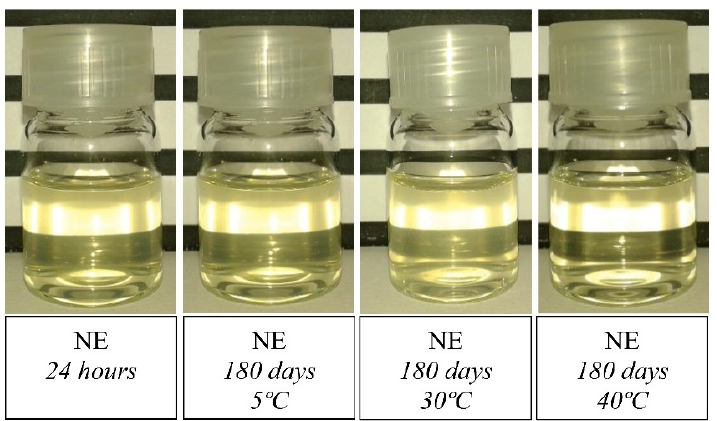
Figure 2. Pictures of the HA-based nanoemulsion containing P. pubescens oil stored for 180 d at temperatures of 5, 30, and 40 °C.